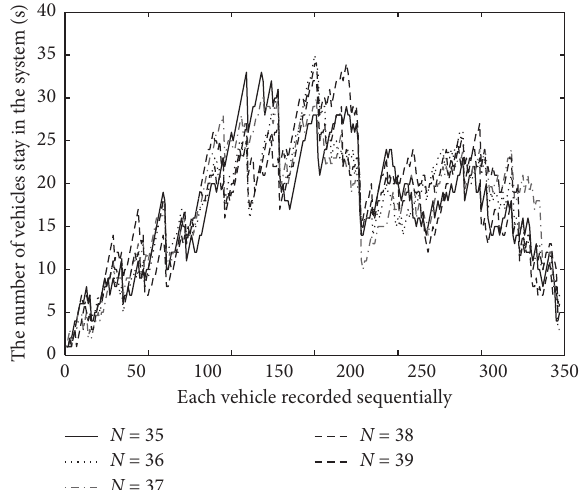
Figure 4: The simulation results with the number of parking ranging from 35 to